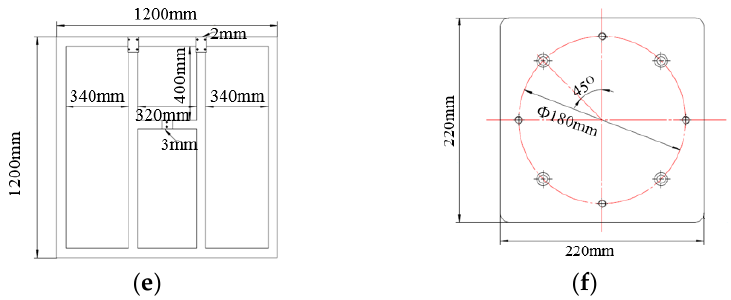
Figure 2. The simple physical model of the radio telescope and its size: ( a ) Telescope model; ( b ) The size of the whole structure; ( c ) The size of the fixed platform; ( d ) The size of the main reflector; ( e ) The size of the pedestal; ( f ) The size of the iron plate.